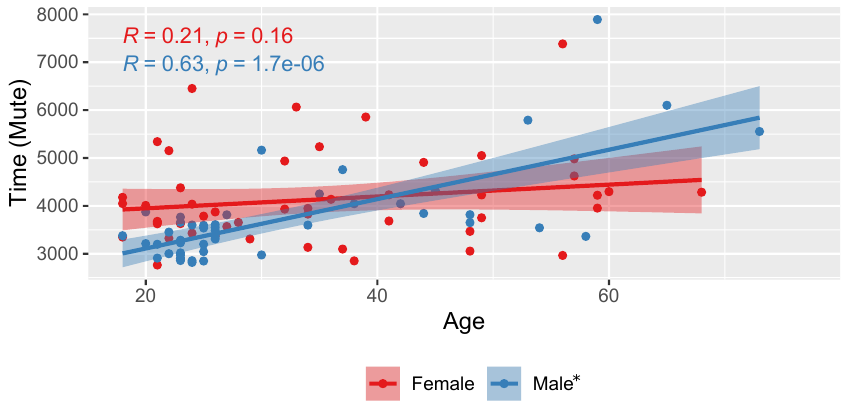
Figure 13. Times of activation versus Age in Mute condition: correlation for males and females dis- played using a scatter plot with regression lines and 95% confidence interval. Significant correlations are marked with asterisk.